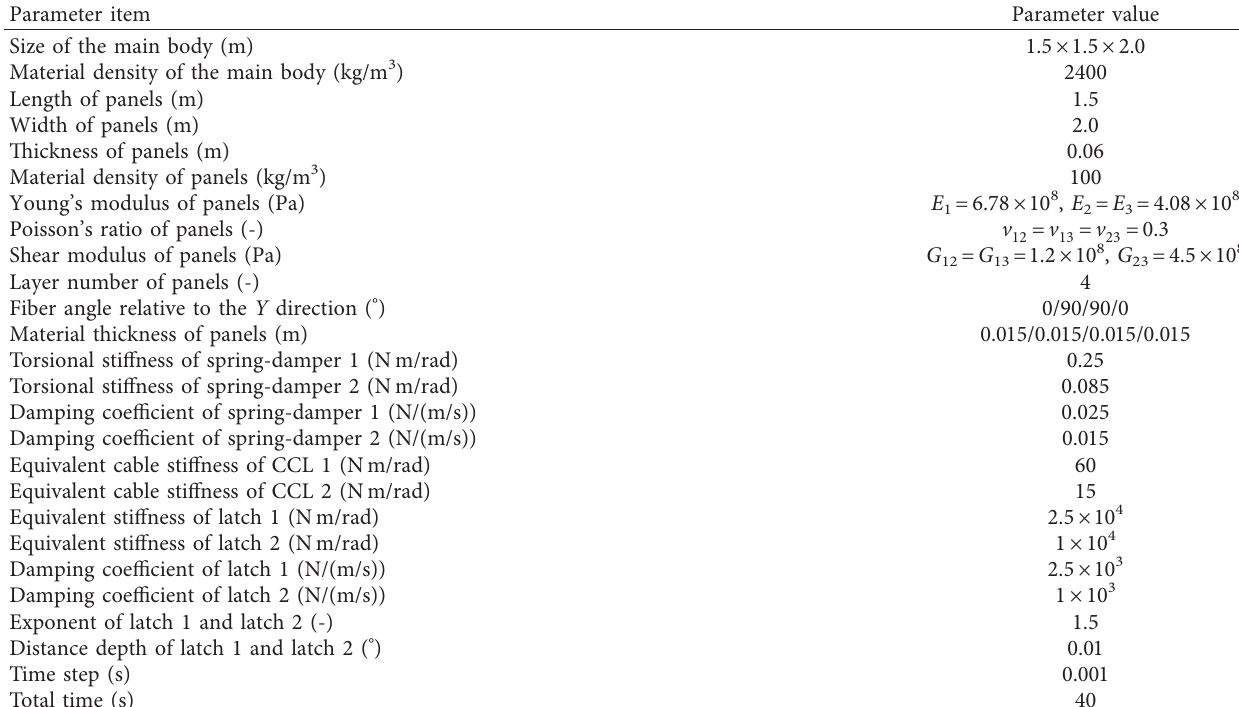
Figure 7: Deoployment process of the solar array. Table 1: Physical parameters of the spacecraft